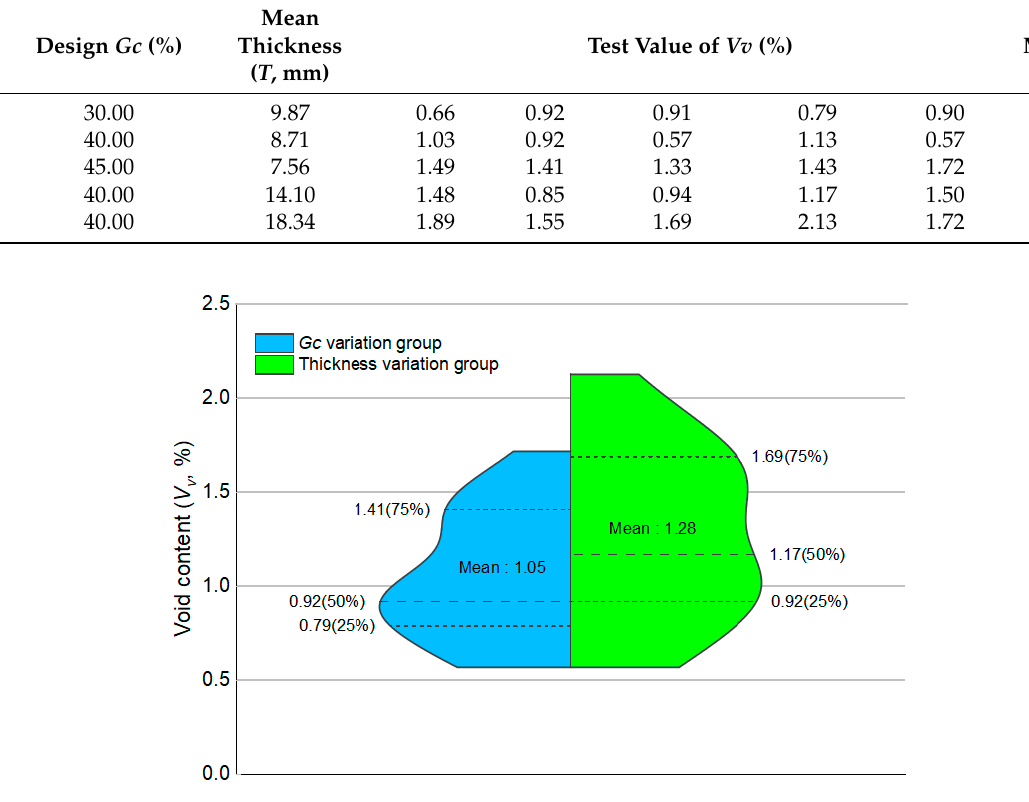
Figure 12. Comparison of void volumes within the hull plate ( Gc variation group vs. thickness variation group).